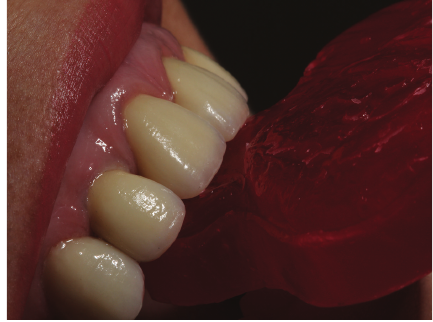
Figure12:Dual-curingresincementplacementontheinnersurface of all-ceramic restoration.